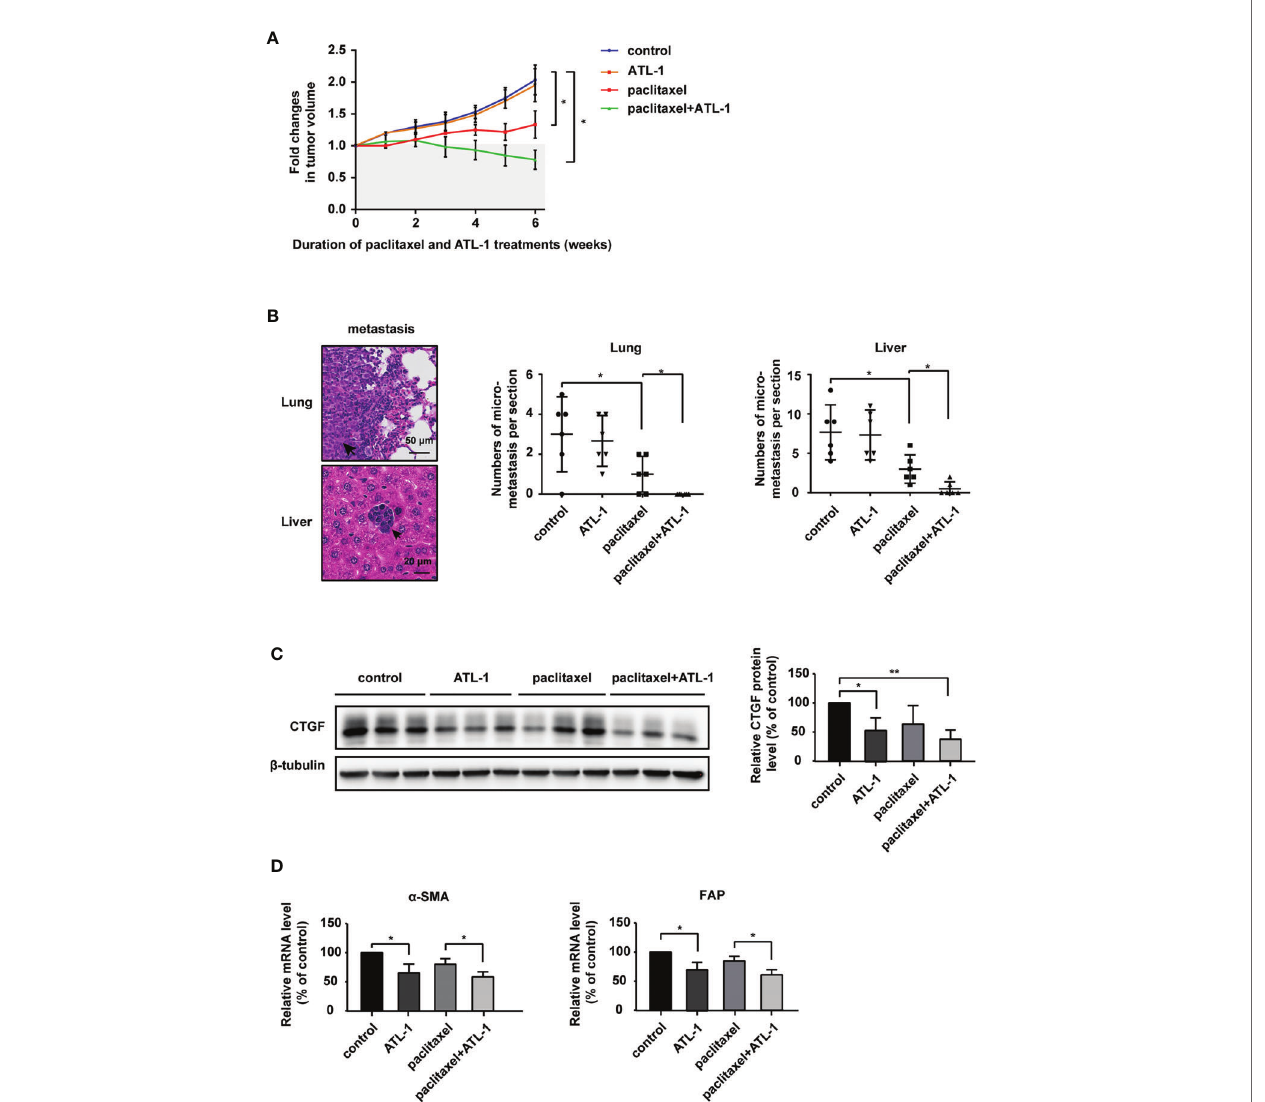
FIGURE 6 | Atractylenolide-I sensitizes triple-negative breast cancer to paclitaxel in a mouse model. (A) MDA-MB-231 cells were inoculated orthotopically into the mammary fat pad of 6-week-old female Balb/c mice (n = 6). When the tumors reached approximately 3 mm in diameter, paclitaxel treatment and ATL-1 treatment were started. Primary tumor size was measured and quanti fi ed every three days for 6 weeks. The abscissa represents the time after the start of treatment. (B) Representative images of metastatic tumors in lungs and liver, which were stained with HE. The numbers of micrometastatic lesions in the lungs and liver were quanti fi ed. (C) The expression of CTGF in primary tumors was examined by Western blotting. (D) qRT-PCR was performed to evaluate the mRNA levels of the CAF markers FAP and a -SMA in primary cultured fi broblasts derived from inoculated tumors. (A, B) Mean ± SD, *p < 0.05 by Student ’ s t test. (C, D) Three independent experiments were performed for each of the Balb/c mice in the four groups. Mean ± SD, *p < 0.05, **p < 0.01 by Student ’ s t